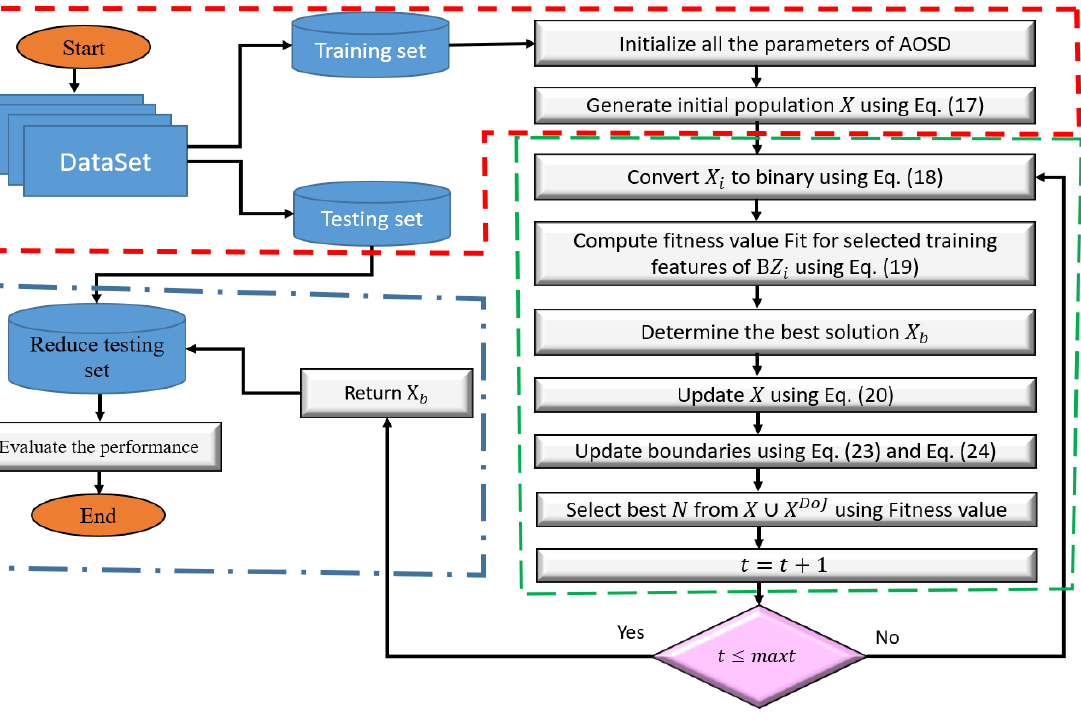
Figure 1. Steps of AOSD for FS